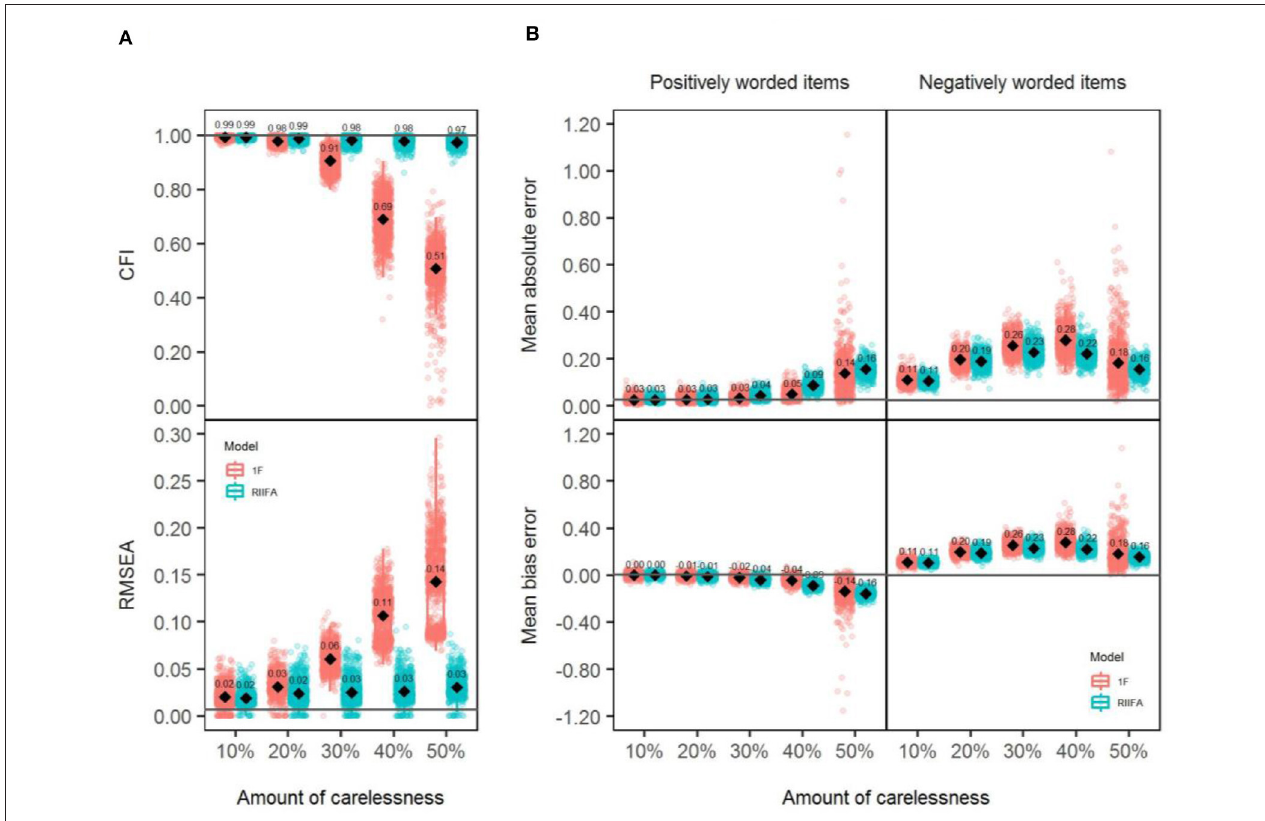
FIGURE 2 | Model fit and recovery of substantive factor loadings for the unidimensional (1F) model and the random intercept item factor analysis (RIIFA) model in the presence of carelessness. 1F, unidimensional model with one substantive factor; RIIFA, random intercept item factor analysis model with one substantive factor and one wording method factor. In (A) , the horizontal gray lines represent the mean CFI and RMSEA values for the condition with 0% of wording effect. In (B) , the horizontal gray lines represent the mean absolute error and the mean bias error for the condition with 0% of wording